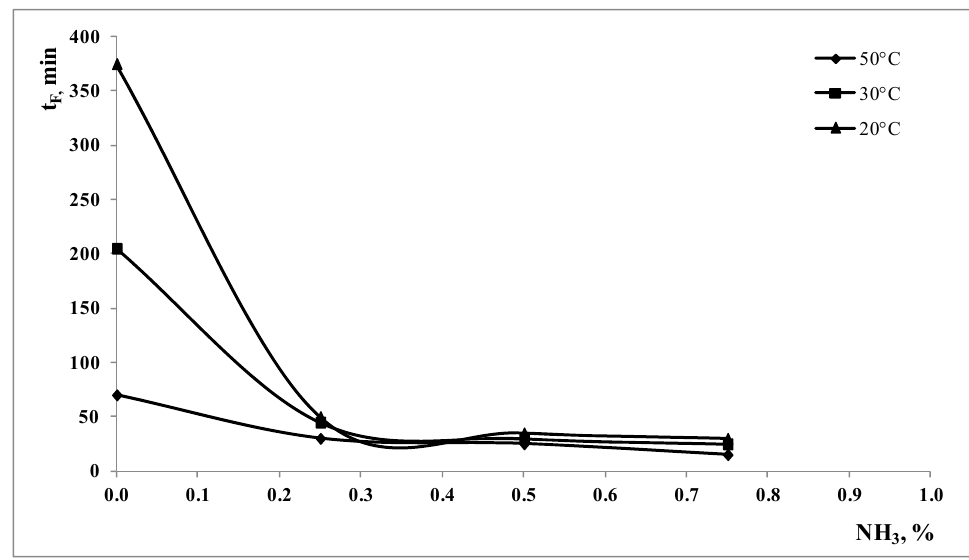
Figure 5. Time necessary to completely remove all the non-polymeric components, t f , at the maximum power as a function of the ammonia concentration and different temperatures.